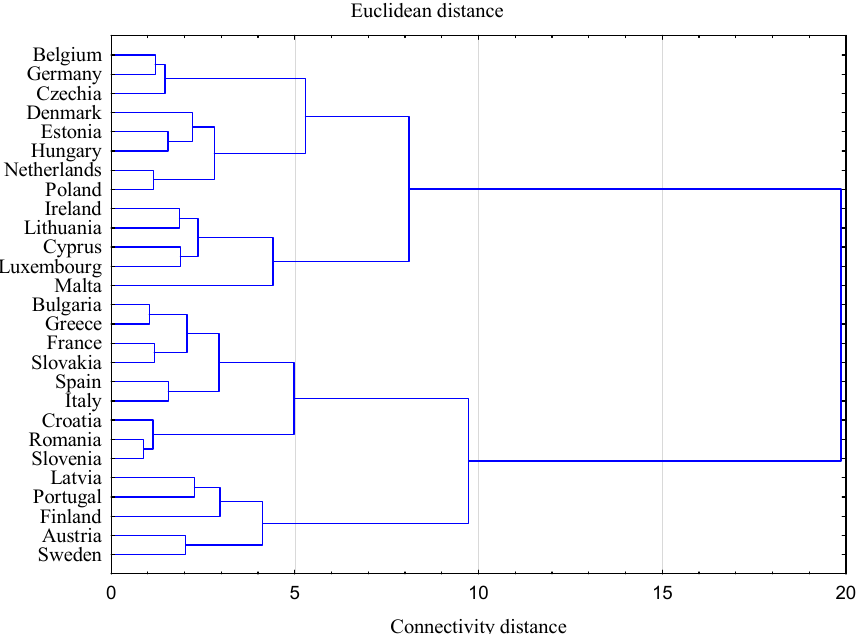
Figure 3. Clustering of EU countries with similar levels of RES development in 2012. Source: author’s own study.